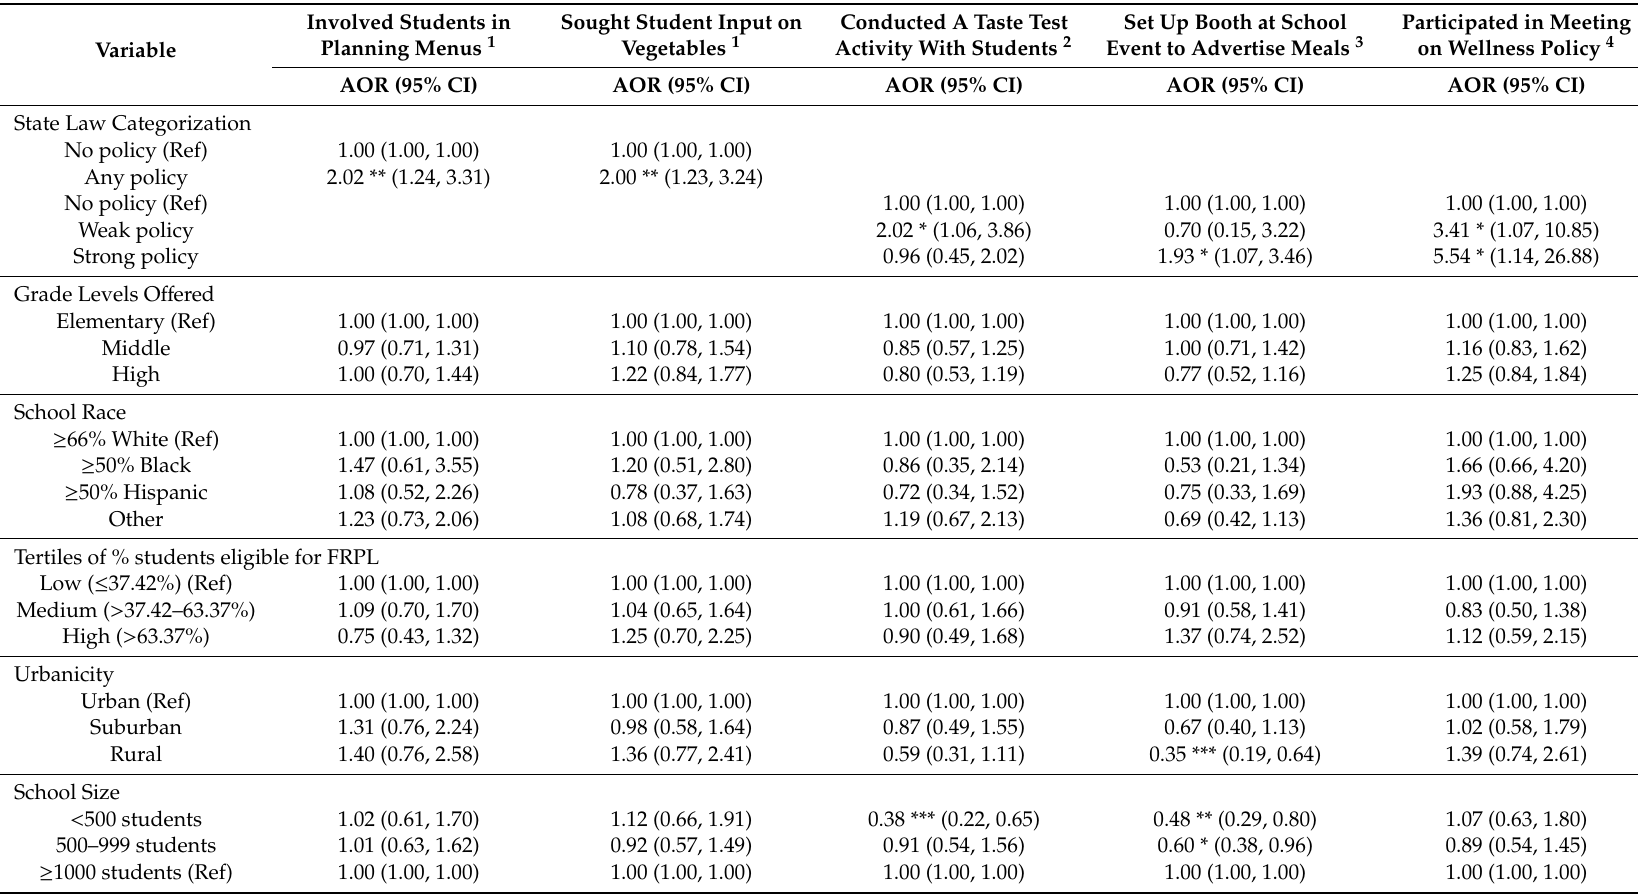
Table 4. Logistic Regression Results for the Association between State Law and School Nutrition Manager